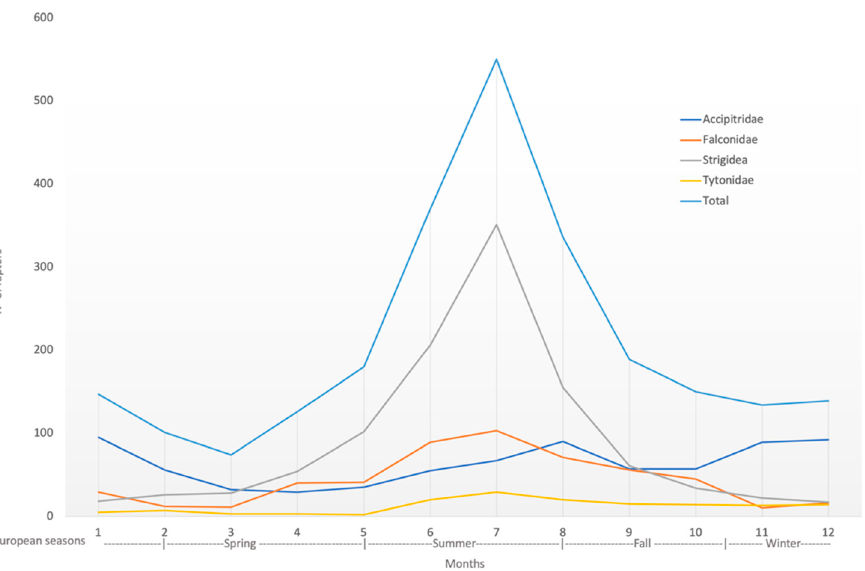
Figure 2. Seasonal overall trend of birds of prey admitted during the study period of 2005–2016, reported by families (x-axis shows the months of the year; y-axis shows the number of raptor specimens).